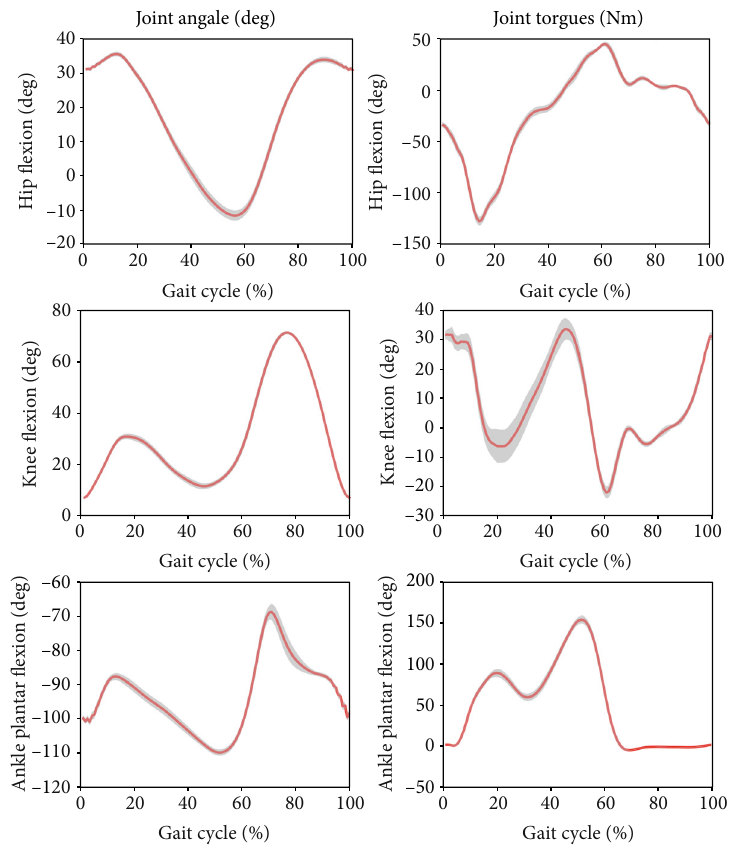
Figure 10: The mean (red) and standard deviation (shaded) of joint angles and torques during preferred-speed walking. These results are from subject AB04 (Trial 3) and include 29 gait cycles.